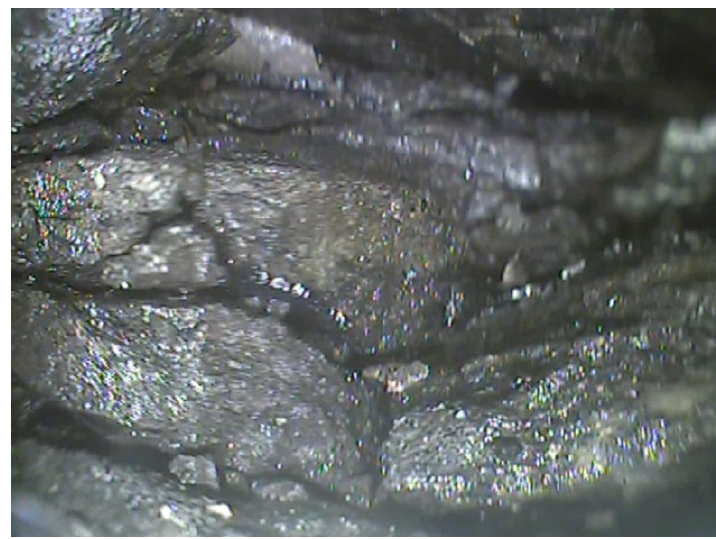
Figure 12. Observation in the 7 m diagonal borehole at a length of 3.5 m.